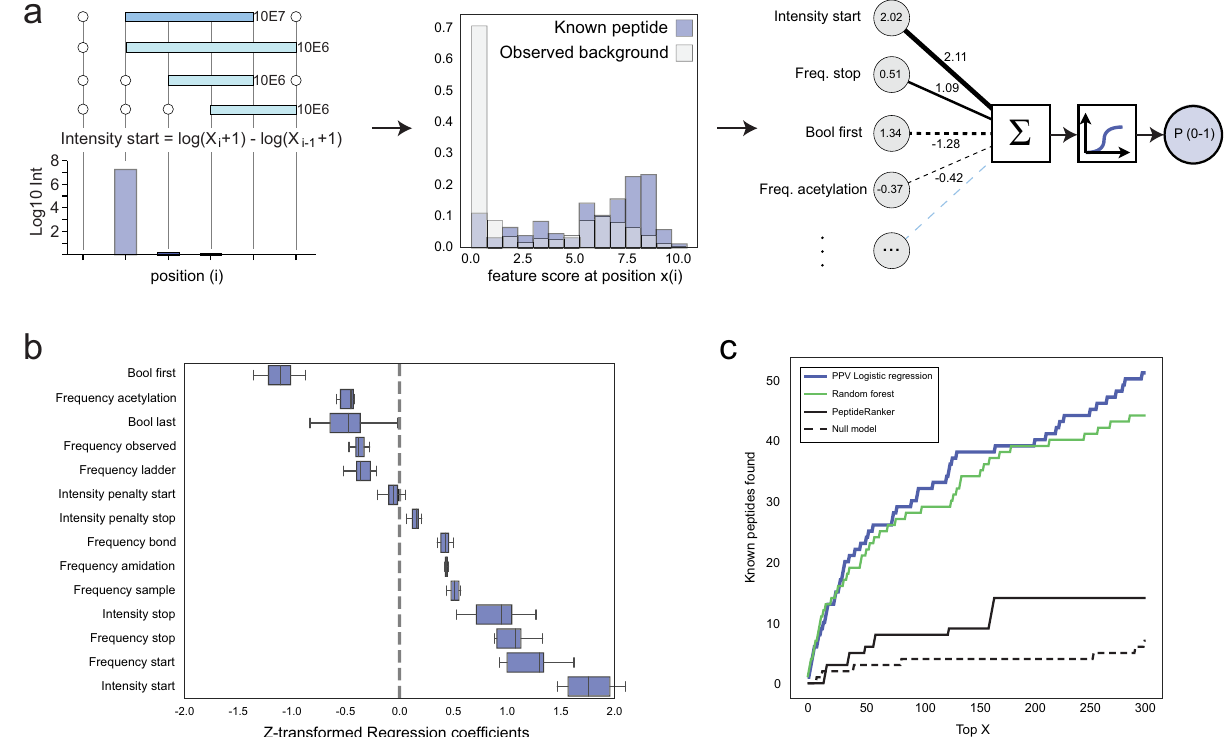
5 times the interquartile range (IQR) of the data, the upper whisker to the highest observed value lower than the upper quartile plus 5 times the IQR. c Number of knownannotatedpeptidesfoundbyeachtypeofmodelasafunctionofrankbased scoring, using nested cross-validation. PPV model based on Logistic Regression (solid blue), Random forest (green), PeptideRanker (solid black), Null model (dot- ted black); model uses only a single input feature, the log 10 (total peptide abun- dance). See Supplementary Fig. 7 and Supplementary Note 1 for description of the different models, features and model development. Source data are provided as a Source Data fi